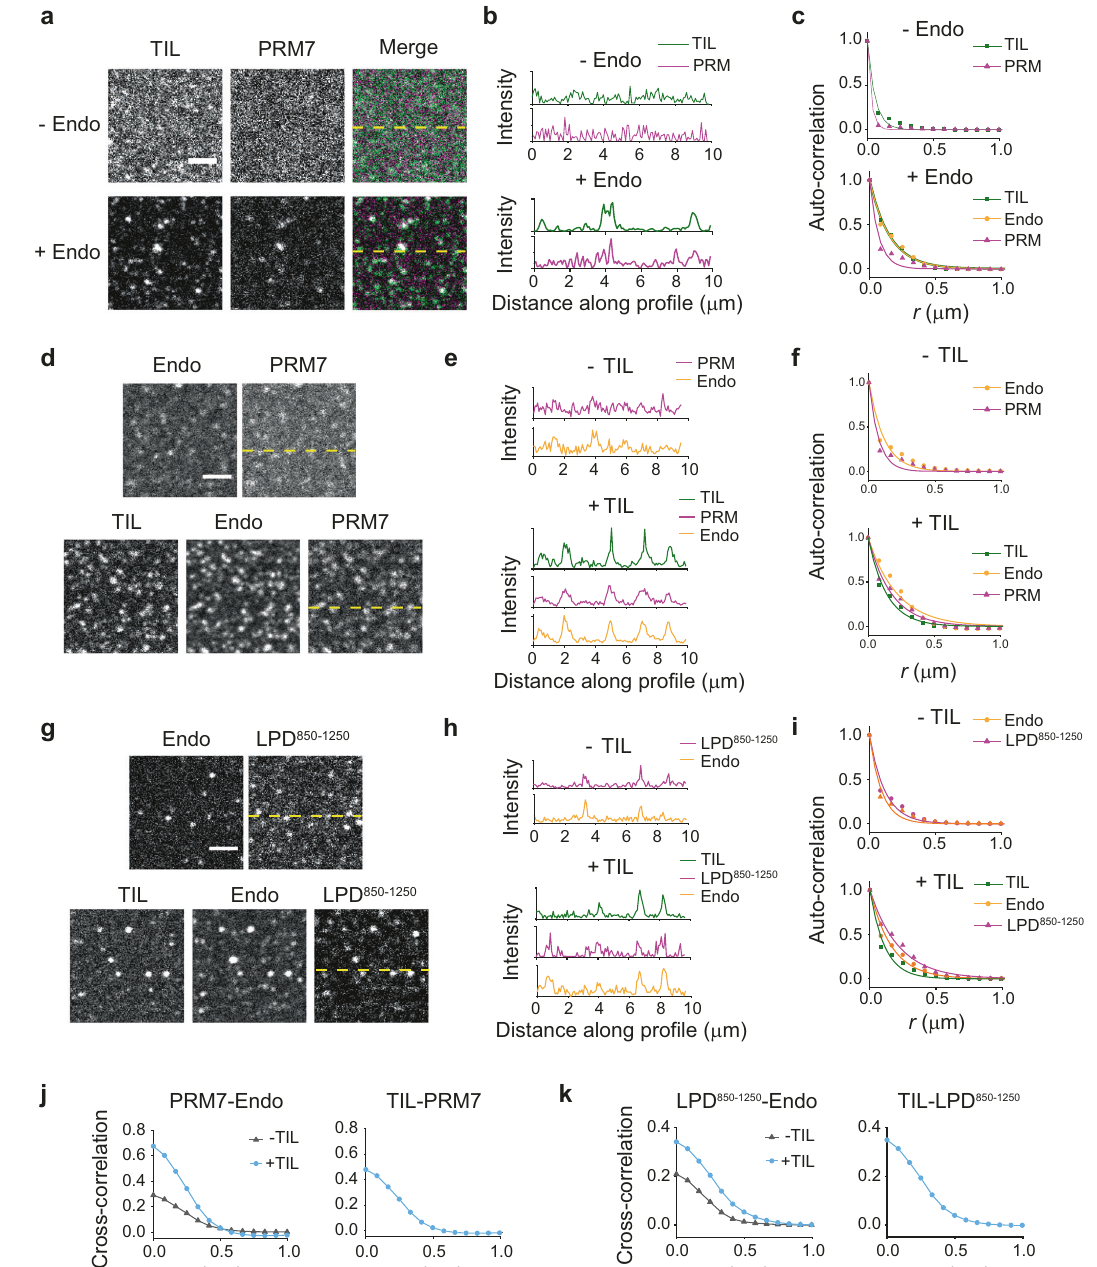
Fig. 5 | TIL partitions into pre-existing endophilin – LPD clusters on the mem- brane and further enhances clustering. a Confocal images of SSBs with con- jugated His 6 -tagged TIL (Alexa 488) and PRM7 (Alexa 633) in the presence and absence of endophilin (10% Alexa 594 labeled). Scale bar 2.5 µ m. b Fluorescence intensity pro fi les for the images along the dashed yellow lines shown in a demonstrating the extent of co-localization of TIL and PRM7 within the clusters. c Radiallyaveragednormalizedautocorrelationfunctionsanditssingleexponential fi ts (solid lines) demonstrating the clustering in the TIL, PRM7, and endophilin channelsbefore(left)andafter(right)additionofendophilin. d Proteindistribution on the SSBs containing tethered PRM7 and endophilin before and 15min after addition of TIL (50nM). e Fluorescence intensity pro fi les for the images along the dashed yellow lines shown in e showing co-localization of TIL and PRM7 into the clusters. f Extent of clustering in the TIL, PRM7 and endophilin channels before (top) and after (bottom) addition of TIL quanti fi ed by radially averaged